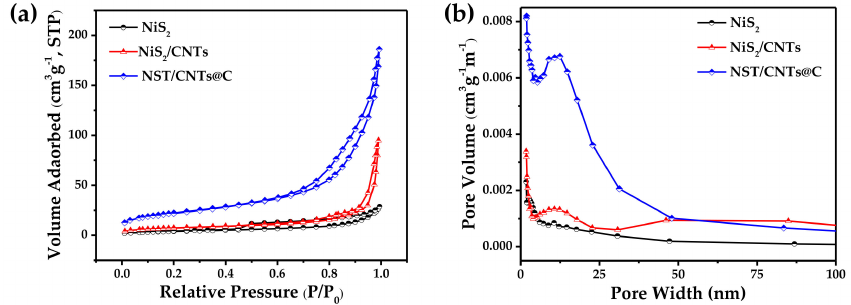
Figure 4. ( a ) N 2 adsorption / desorption isotherms; ( b ) Corresponding pore-size distribution